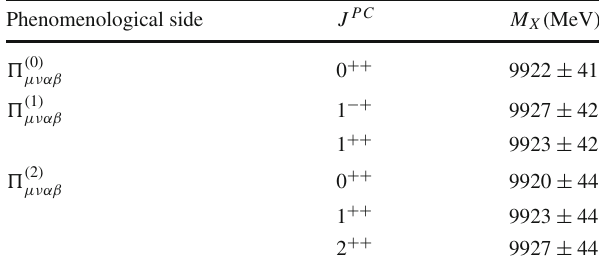
Table 2 Mass spectrum of ¯ bb